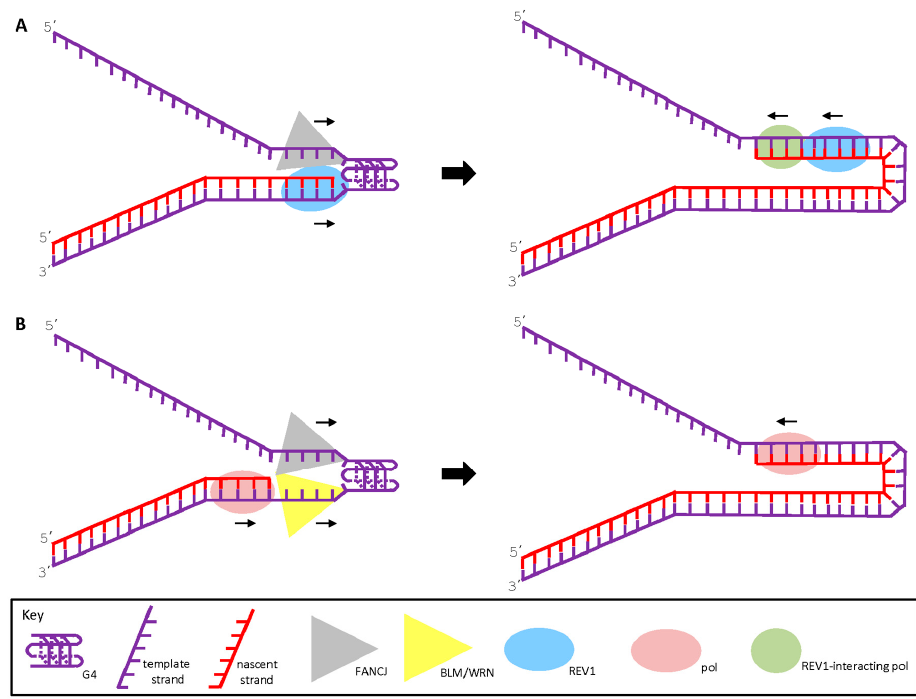
Figure 2. Proposed models for how FANCJ protein interactions provide a mechanistic opportunity to resolve G4 structures to enable smooth DNA synthesis. ( A ) FANCJ interacts with the TLS polymerase REV1 at the site of a G4 structure, enabling it to catalyze DNA synthesis past the G4 obstacle. A REV ‐ 1 interacting polymerase is likely to also be involved; ( B ) FANCJ interacts with the BLM (or WRN) helicase to efficiently resolve the G4 DNA structure, making the single ‐ strand template accessible to a replicative DNA polymerase. For either model, the role of FANCJ may prevail for leading or lagging strand DNA synthesis. See text for details.